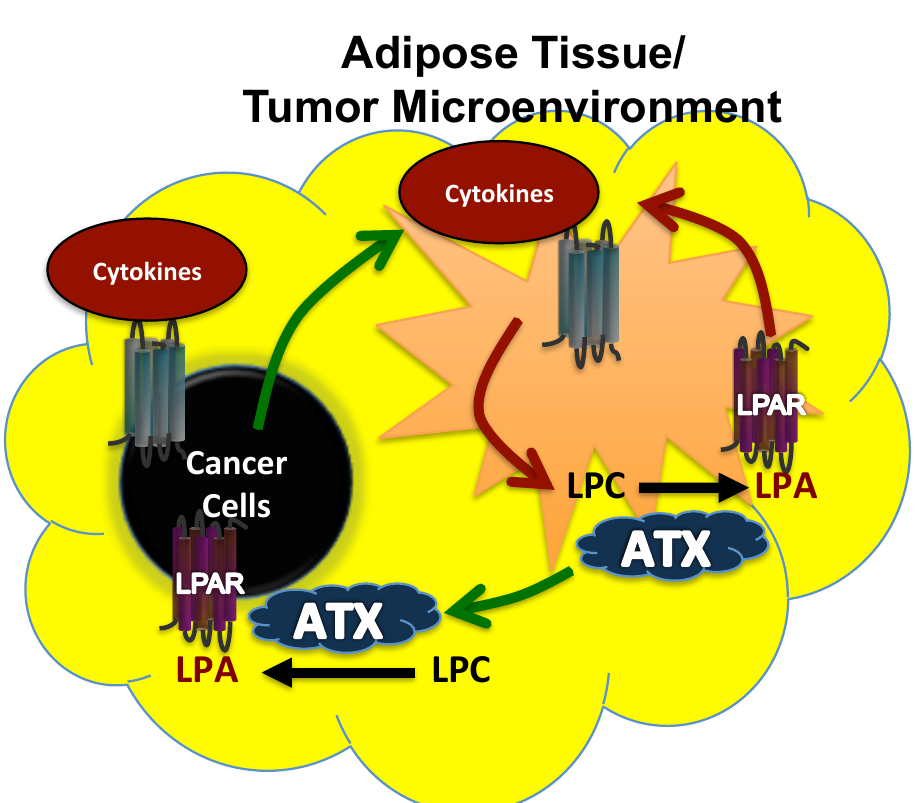
Figure 3. Model for ATX production in breast cancers where the cancer cells produce little ATX themselves. In breast cancers, a paracrine model of ATX secretion is possible because adipose tissue secretes high levels of ATX, whereas breast cancer cells normally produce negligible ATX. As the tumor grows, proinflammatory signals (cytokines) secreted by the tumor create an inflammatory environment within the surrounding adipose tissue and tumor microenvironment (green arrows). This signaling increases ATX secretion and LPA production, which in turn can establish an autocrine feed forward loop of increased cytokine signaling and ATX production (red arrows) within the adipose tissue and tumor microenvironment. Increased ATX and LPA production contribute to tumor progression (green arrows). Figure adapted and modified with permission from [31].